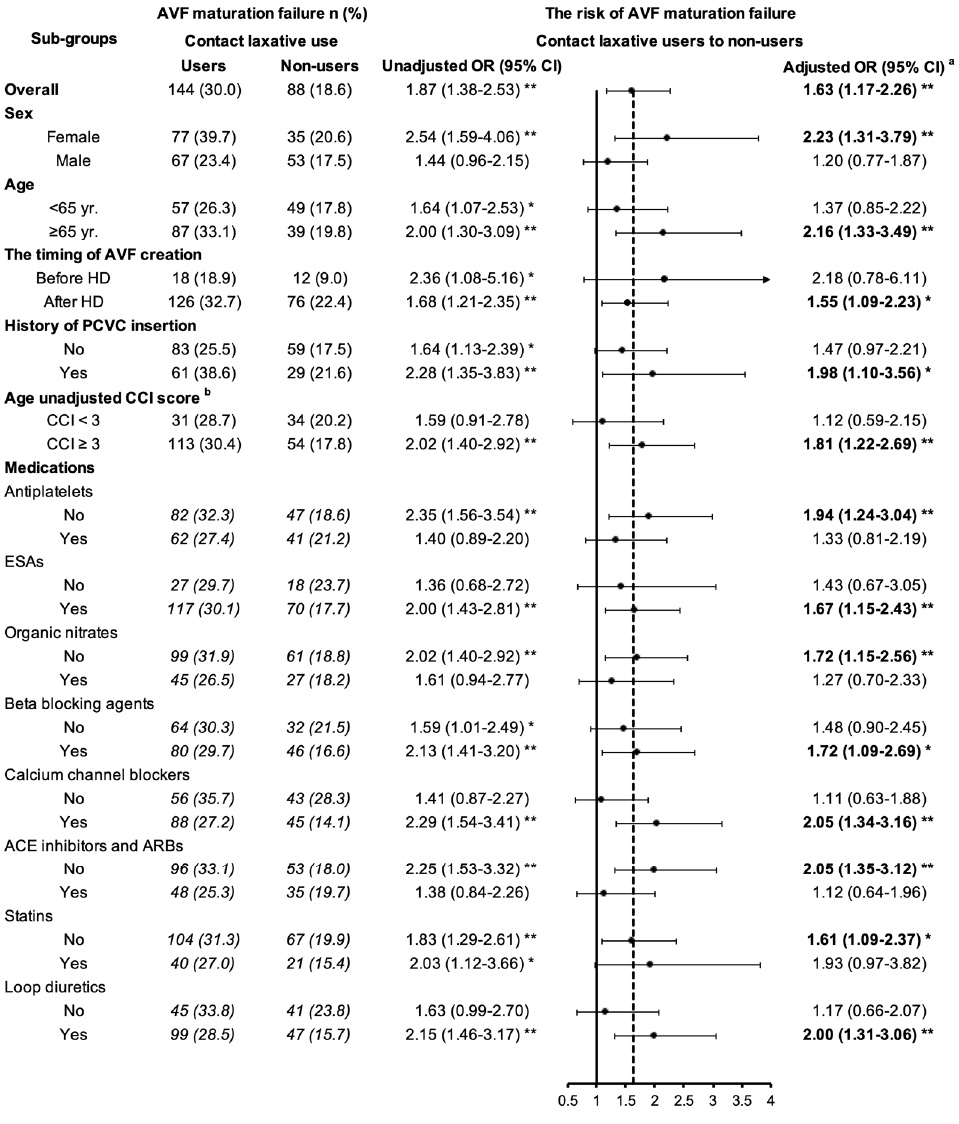
Figure 2. Laxatives use and their association with AVF maturation failure by different covariates. Note: AVF—arteriovenous fistula; yr.—year; HD—hemodialysis; PD—peripheral dialysis; CCI— Charlson Comorbidity Index; ESAs—erythropoietin stimulating agents; ACE inhibitors—angiotensin- converting enzyme inhibitors; ARBs—angiotensin receptor blockers. a Adjusted OR (adjusted odds ratio) was estimated using multiple logistic regression model and adjusted for covariate factors, including age, gender, history of dialysis and vascular access, Charlson Comorbidity Index score, laboratory examinations, and medications listed in Table 1. b Charlson score represents the degree of health; a high score indicates a worse health condition. * p < 0.05; ** p <